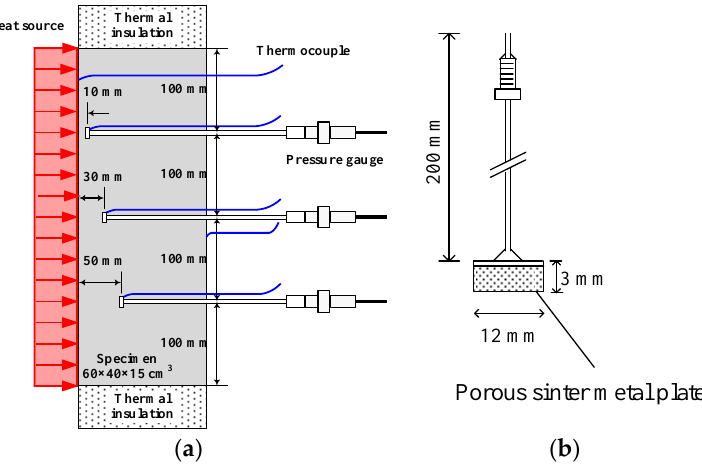
Figure 3. Scheme of the experimental setup: ( a ) arrangement of thermocouples and pressure gauges in the slab specimens; ( b ) structural diagram of the pressure pipe.